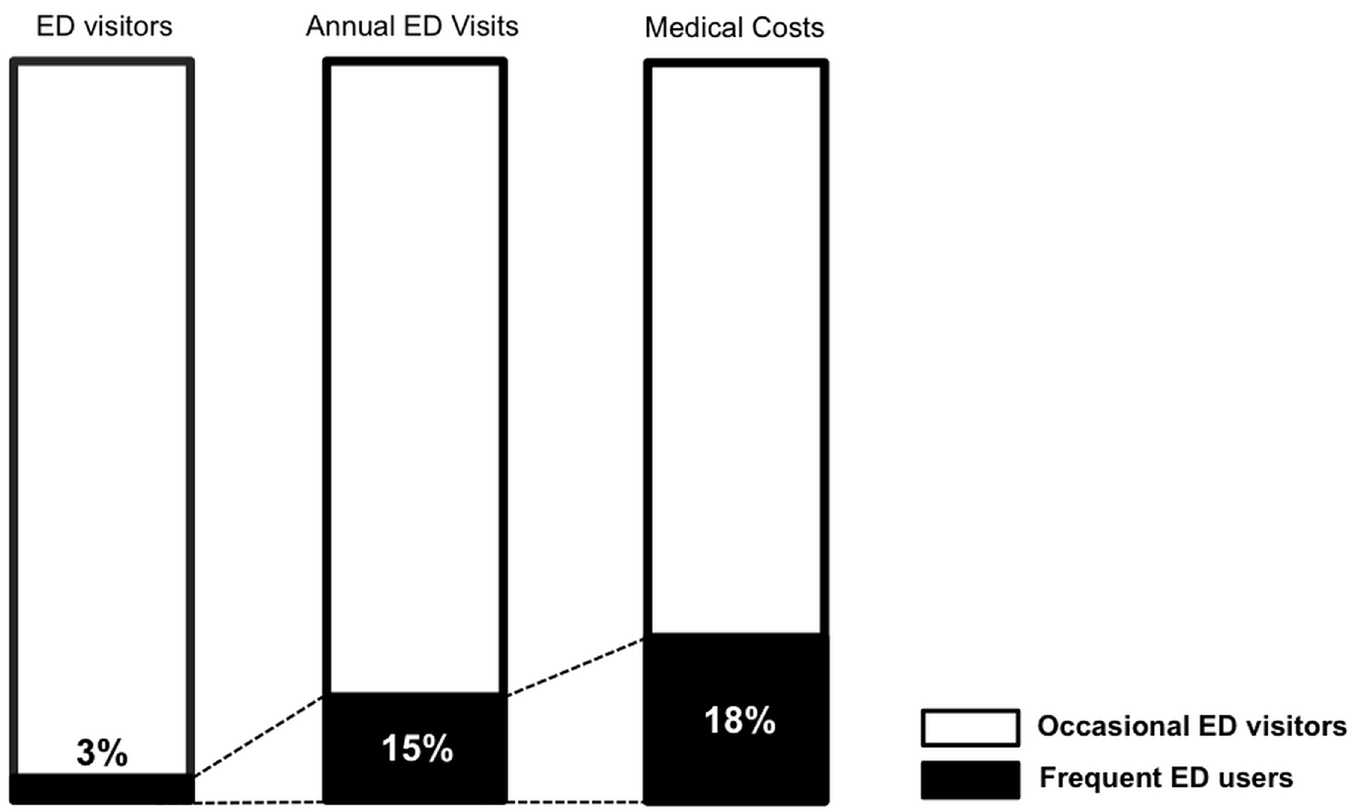
Fig 1. Number of visits and costs for frequent ED users. Frequent ED users accounted for about 3% of all ED users, and this 3% of users accounted for 14% of total annual ED visits and 17% of total expenses generated from the all ED